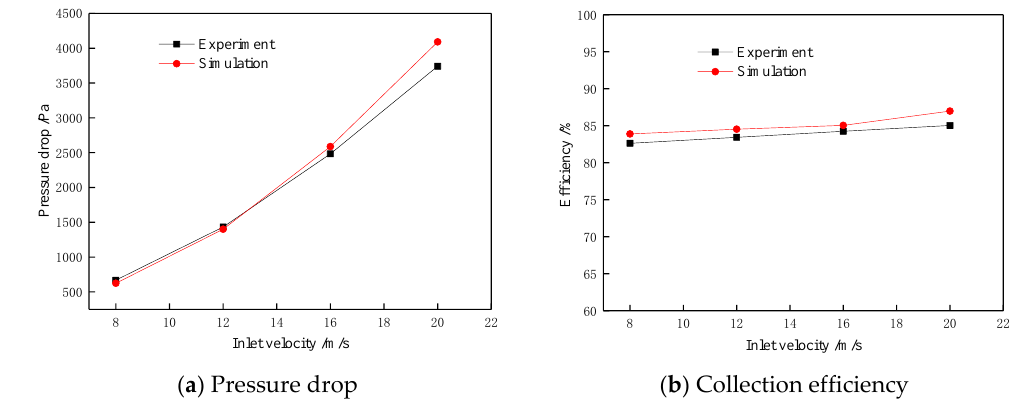
Figure 4. Validation of the simulation results [32].